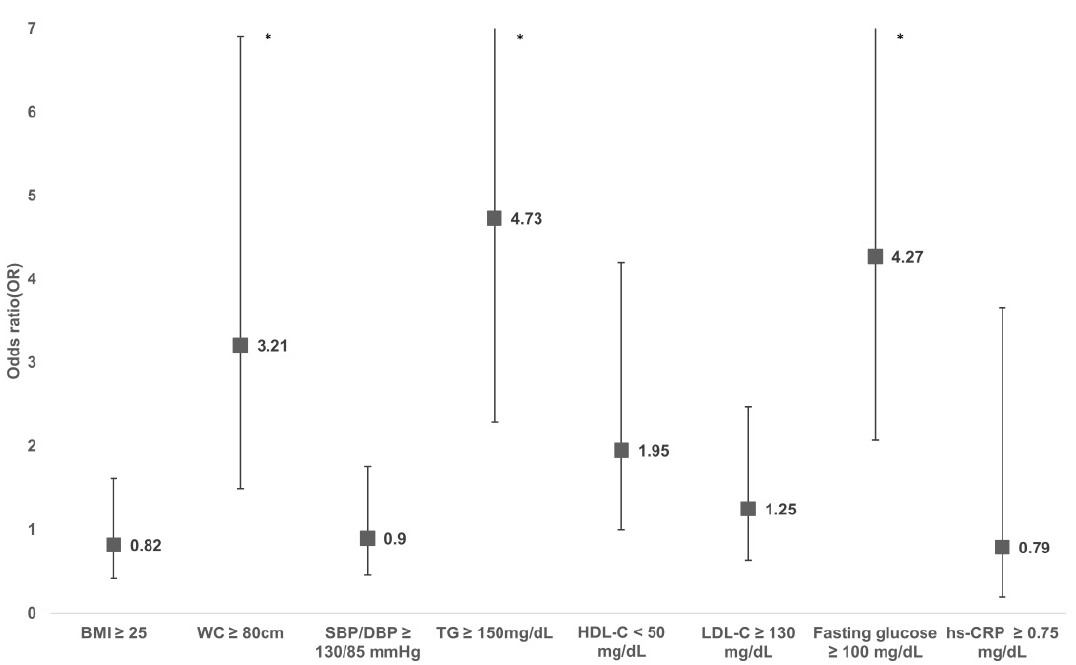
Figure 2. Adjusted odds ratio of cardiometabolic risk factors for adults with FMS compared with those without FMS. Odds ratio was calculated using multi-variable logistic regression adjusting for age, smoking, and alcohol consumption. Asterisk (*) represents p ≤ 0.05.